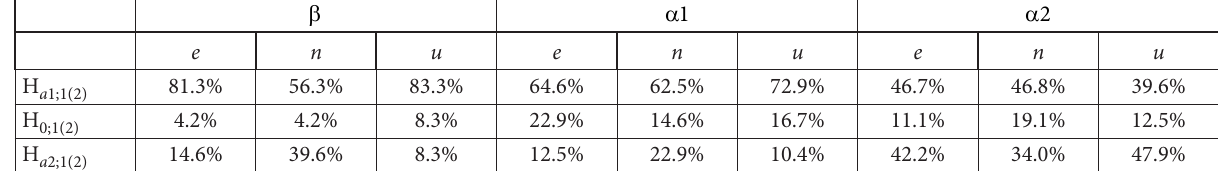
Table 7. Hypothesis acceptance percentage by the relative coordinates ( e , n and u ) for FF MP effect ( b ), the joint effect of NF MP and RAPCOV ( a 1) and the joint effect of TI ( a